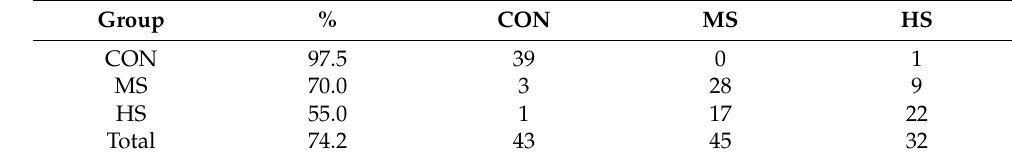
Table 6. Classification Matrix. Rows: observed classifications. Columns: predicted